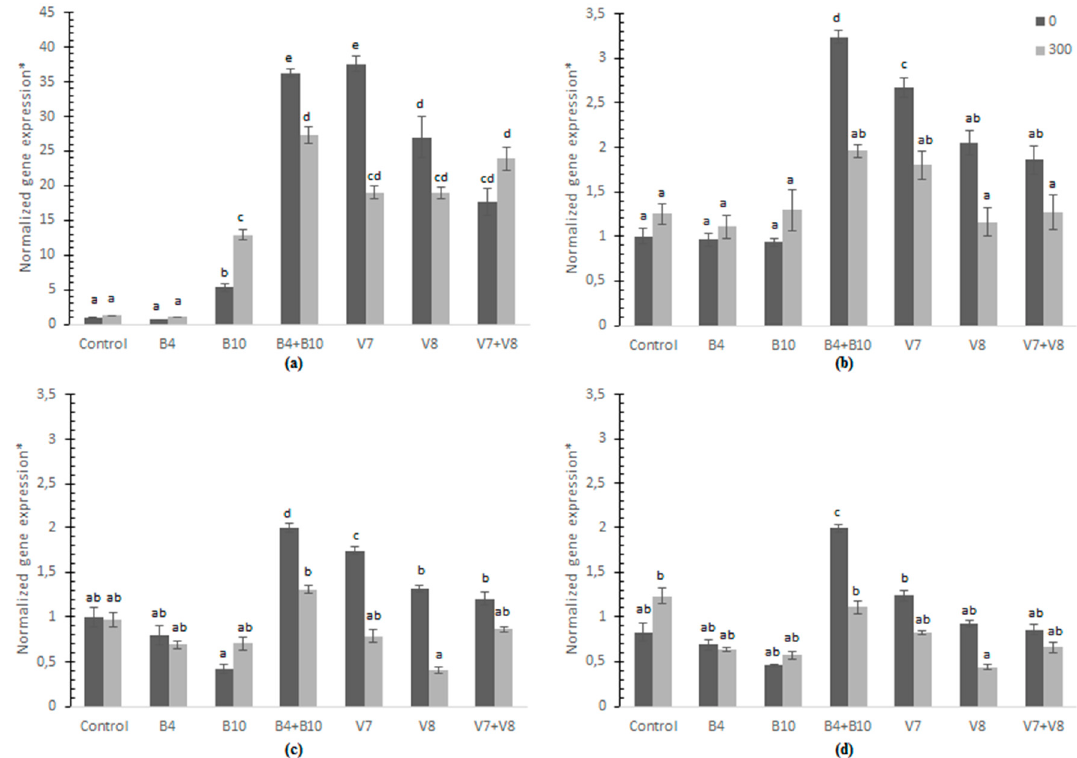
Figure 2. Relative expression of the metallothionein ( MT ) ( a ), superoxide dismutase ( Zn/Cu SOD ) ( b ), ascorbate peroxidase ( APX ) ( c ) and phytochelatin synthase ( PCS ) ( d ) genes in T. aestivum leaves grown in a soil supplemented with 300 mg·Kg − 1 of As and inoculated with P. gessardii (B4), B. intermedia (B10), the mixture of both (B4 + B10), F. rabenhortii (V7), H. viticola (V8), the mixture of both (V7 + V8). The standard deviation is indicated by different bars and letters show statistically significant differences ( p < 0.05). * Normalized to GAPDH and α -TUB